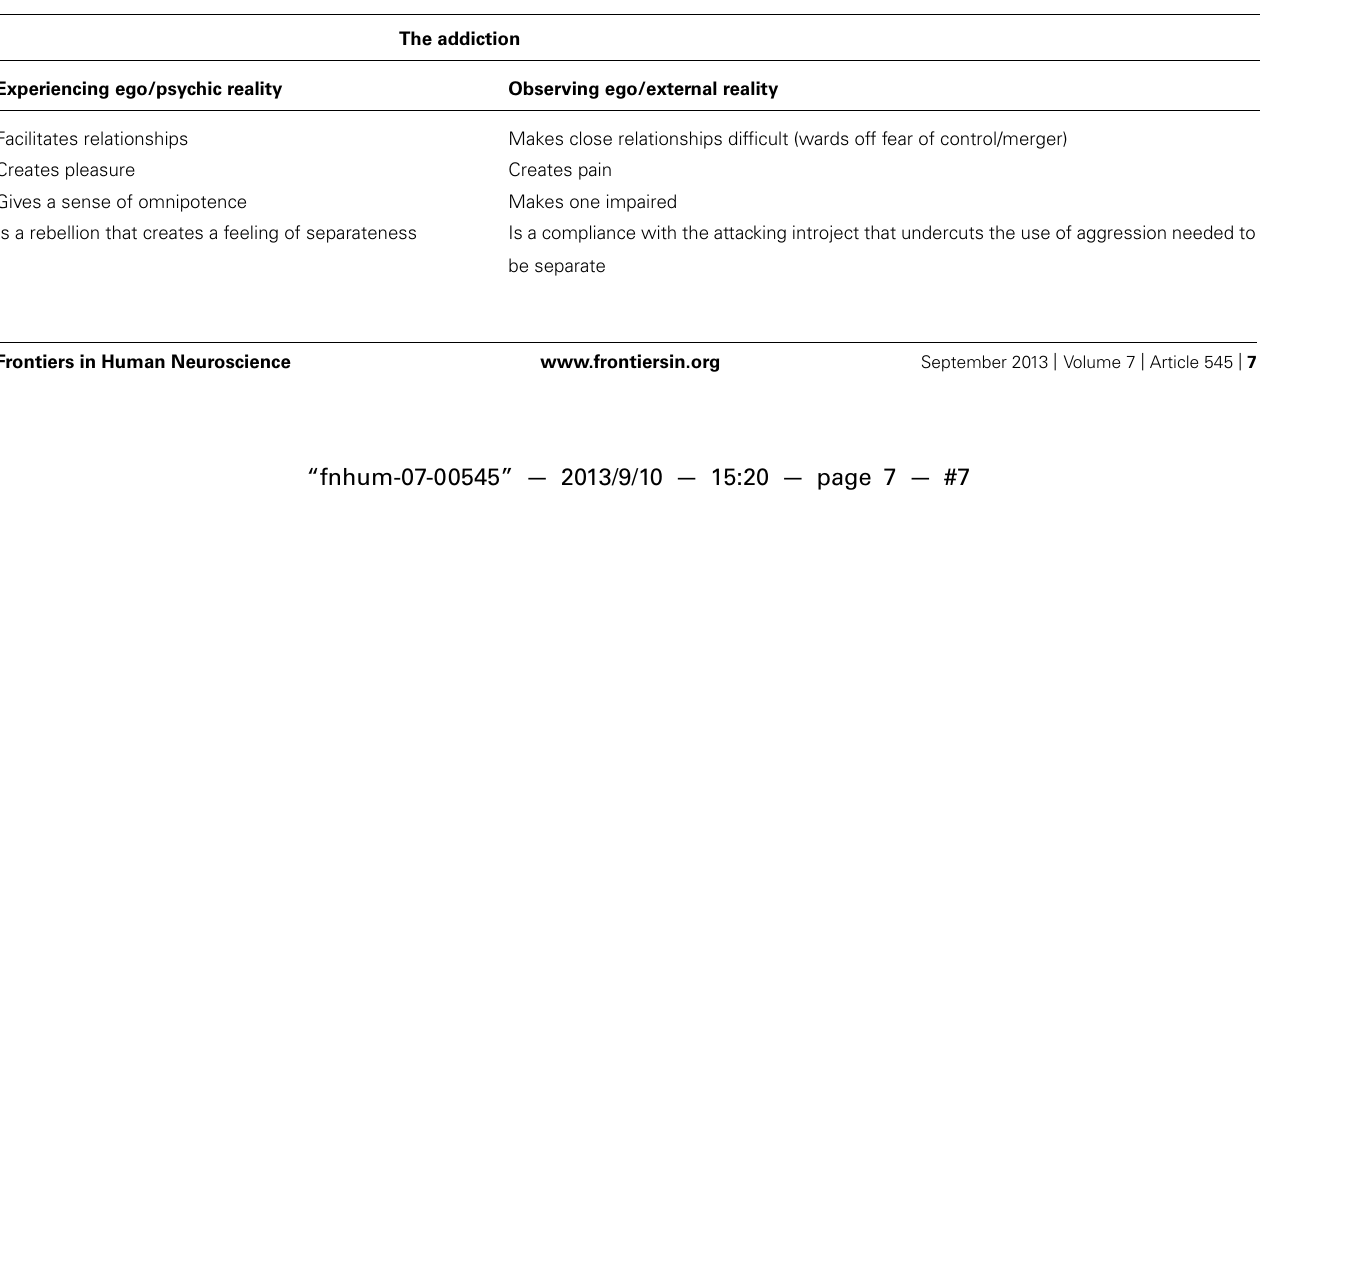
Table 1 |Addictive